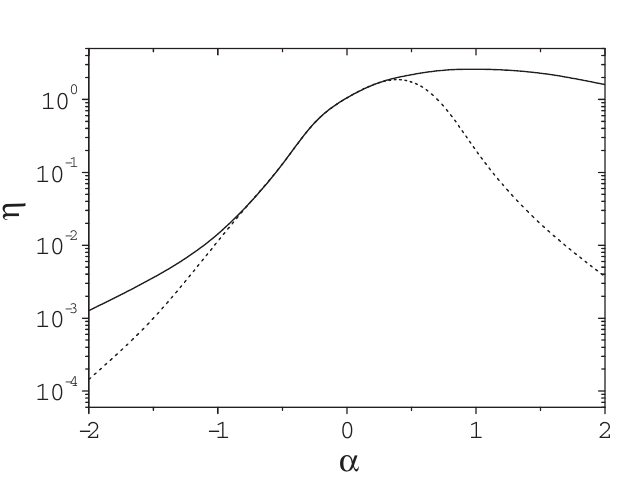
(cid:3) ^ z (cid:1) ^ (cid:4) (cid:2) (cid:5) ^ z (cid:1) 0 (cid:2) sat sat sat